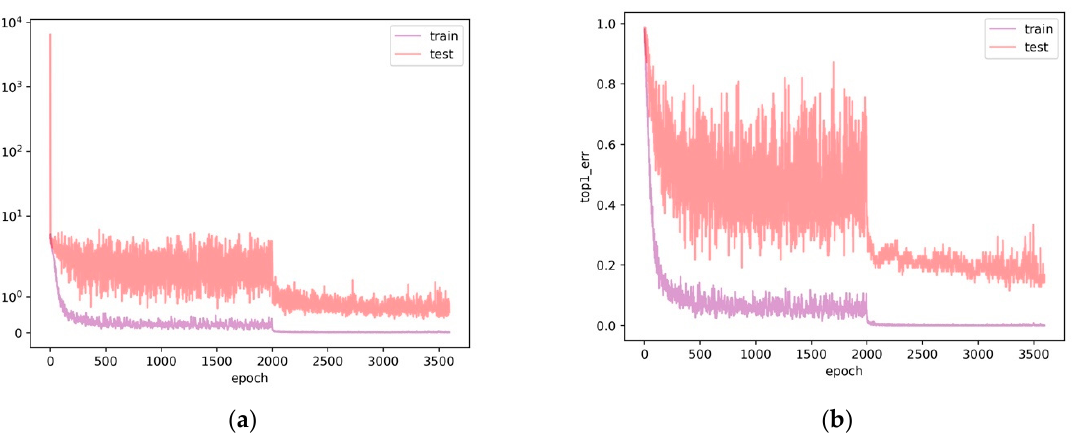
Figure 14. ( a ) The loss curve of the training and testing process on the test set; ( b ) the top1_err of training and testing process on the test set.